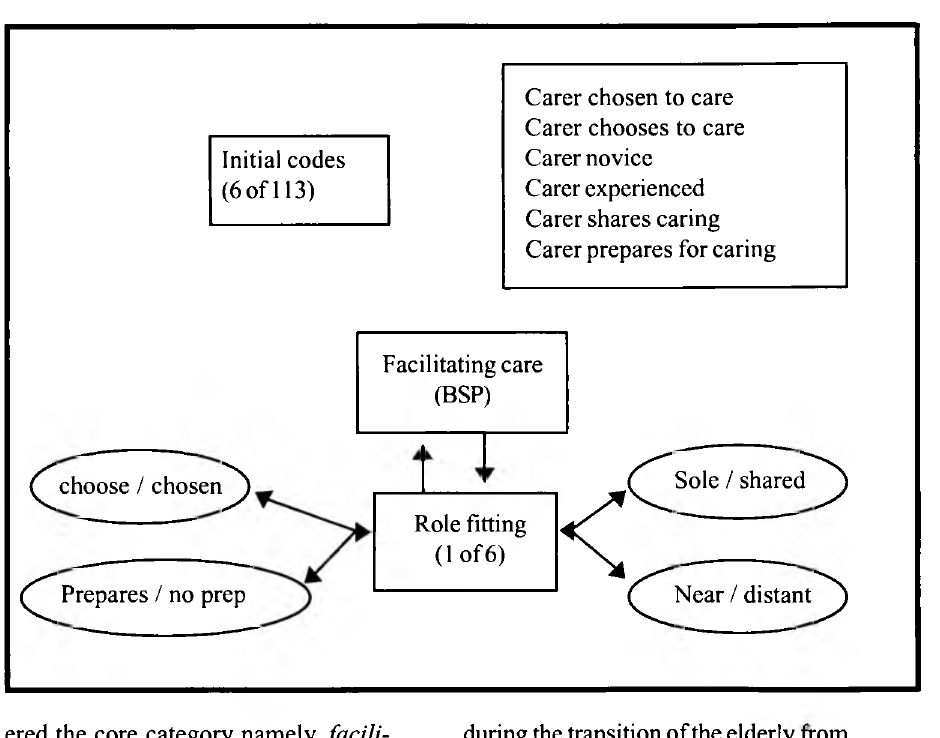
Figure 1: Example of Open